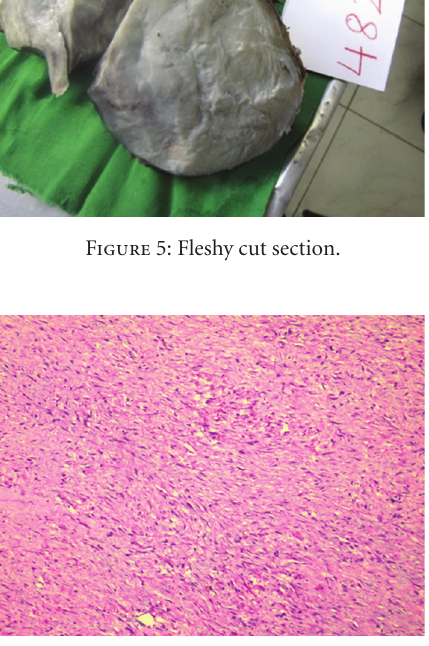
Figure 6: Photomicrograph of the tumour (10x H&E): elongated fascicles of spindle-shaped cells in a background of eosinophilic collagenized stroma.